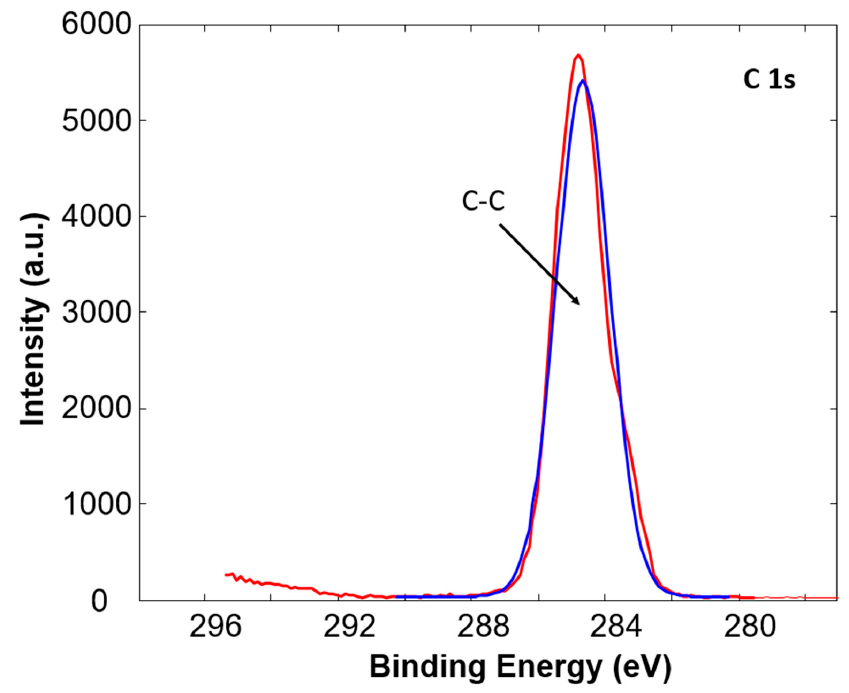
Figure 2. High resolution XPS spectra of untreated Sample 3.